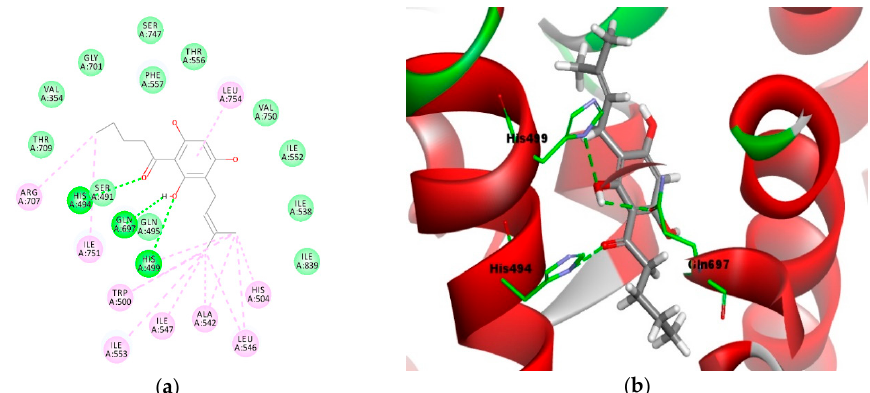
Figure 5. Molecular binding models of compound 4e in the active site of the LOX-1 homology model: ( a ) 2D diagram; ( b ) 3D diagram. In ( a ), green line indicates hydrogen-bonding interactions, light green line indicates covalent bonding, pink line indicates hydrophobic interactions, and purple line indicates π – π interactions. In ( b ), atoms are colored gray for carbon, red for oxygen, blue for nitrogen, and white for hydrogen; amino acid residues are in green.